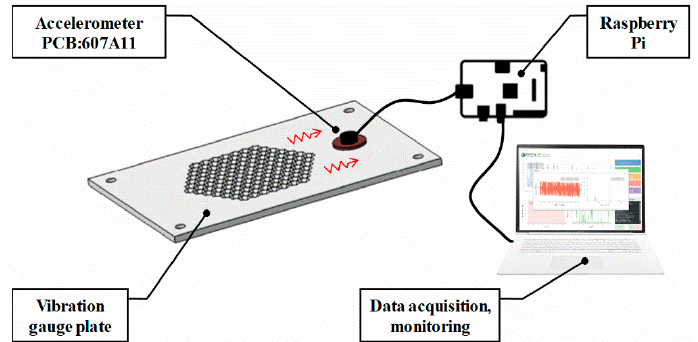
Figure 3. Impact flowmeter system based on the LSTM deep-learning algorithm when using a vibration accelerometer.